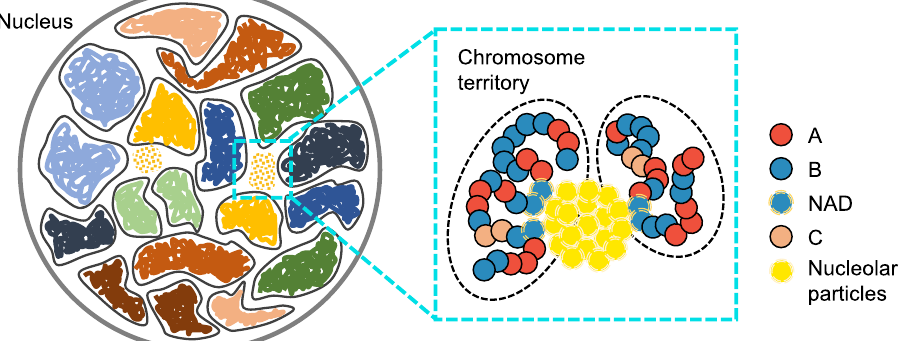
Fig. 1 Overview of the computational model used for studying phase separation inside the nucleus. The diploid human genome model represents each one of the 46 chromosomes as a string of beads con fi ned in the nuclear envelope. Each bead is identi fi ed as compartment type A , B , or centromeric region C . Nucleolar particles share favorable interactions to promote phase separation and bind speci fi cally with nucleolus-associated domains